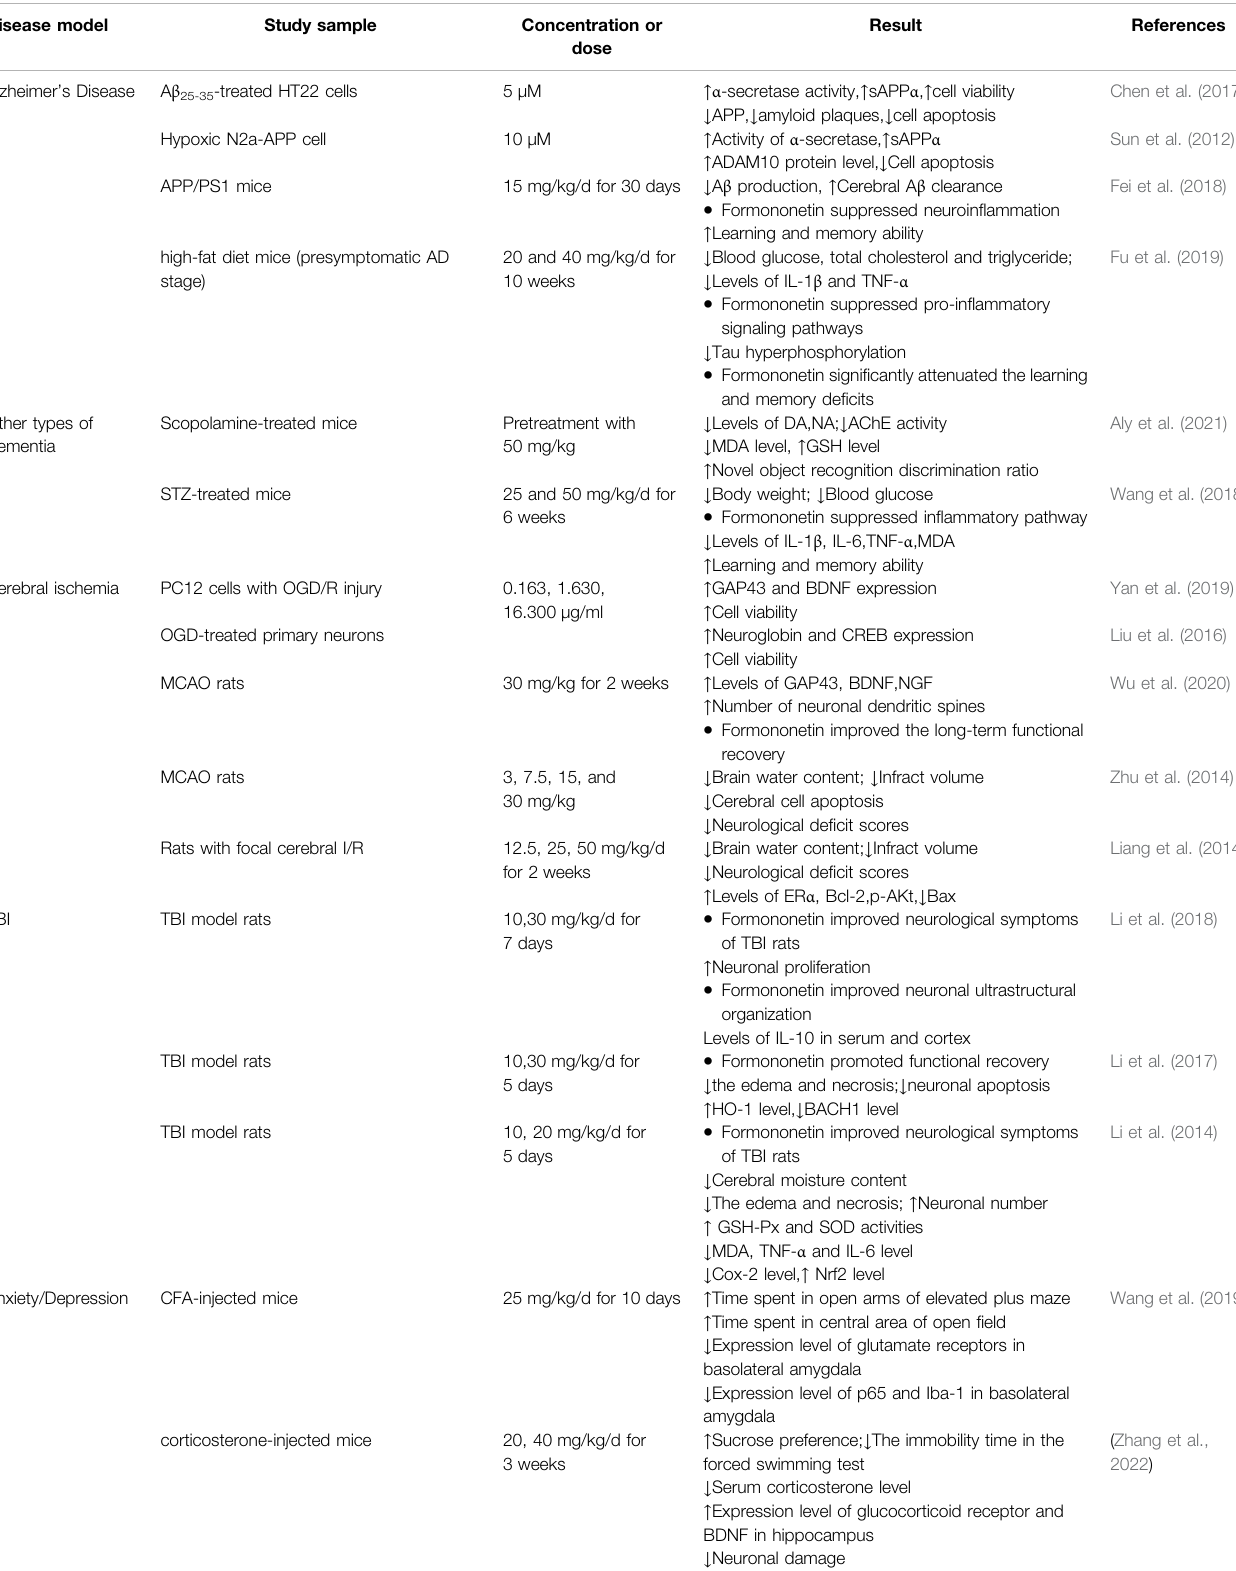
TABLE 1 | Pharmacological activities of formononetin in nervous system related